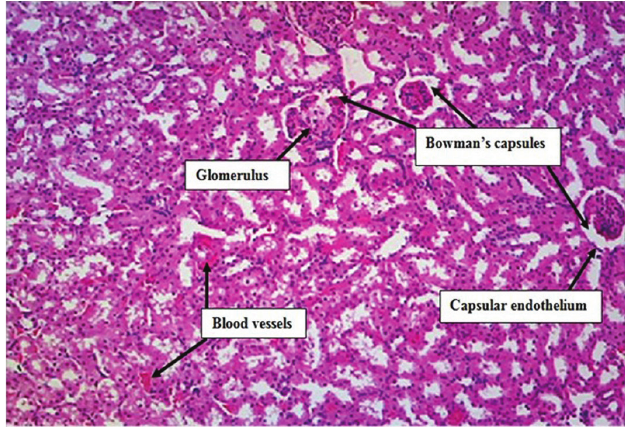
FIGURE 7 - Effect of normal saline on the kidneys of rats (H & E, 100x, 5 µ): Representative image of kidney of rats treated with normal saline orally for three weeks showing thin walled endothelium of Bowman’s capsule, glomeruli with intact cellular borders, blood perfusion and convoluted tubules.